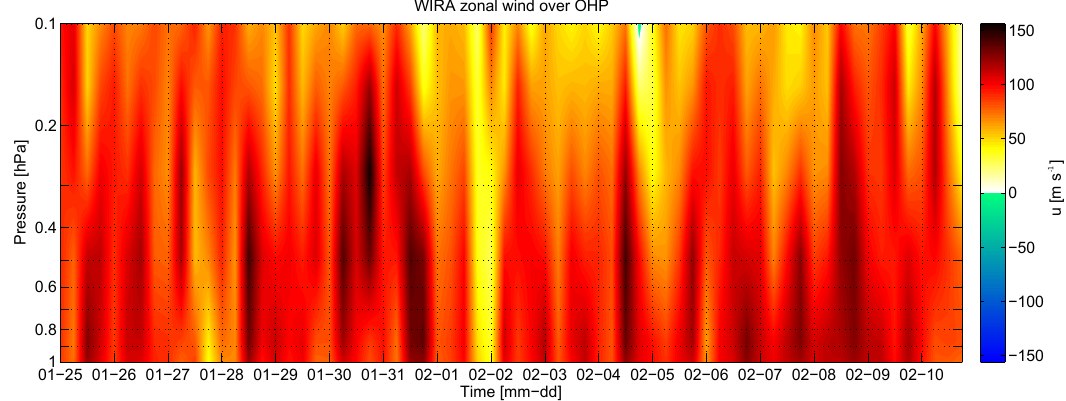
Figure 4. The zonal wind vector component time series (ms − 1 ) measured by WIRA between 25 January and 10 February 2013 in the pressure range 0 . 1–1hPa at the Observatoire de Haute-Provence (OHP) in France.